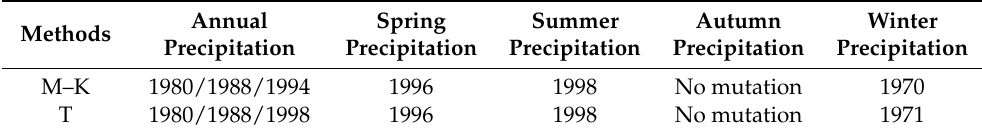
Table 1. Abrupt precipitation change year on the TP based on the M–K test and t -test methods.